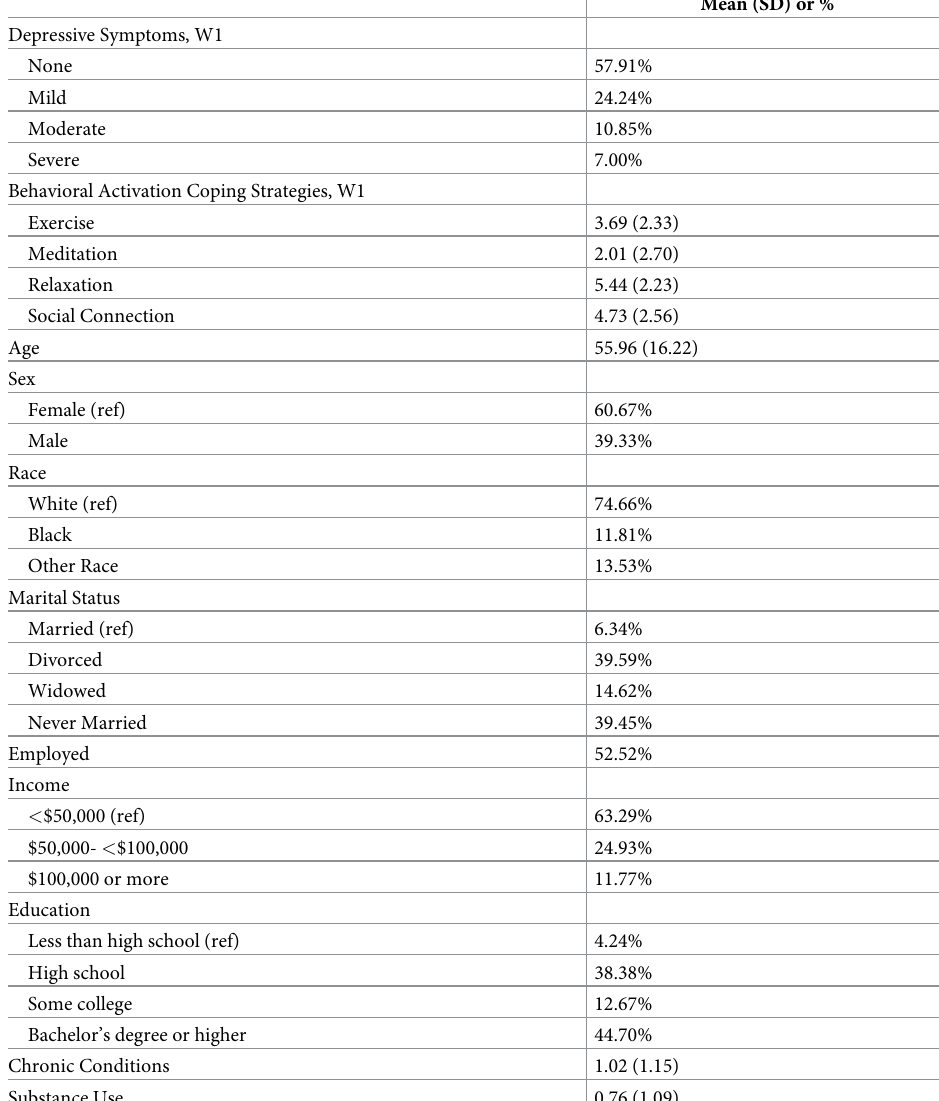
Table 1. Descriptive statistics of the study variables (n =